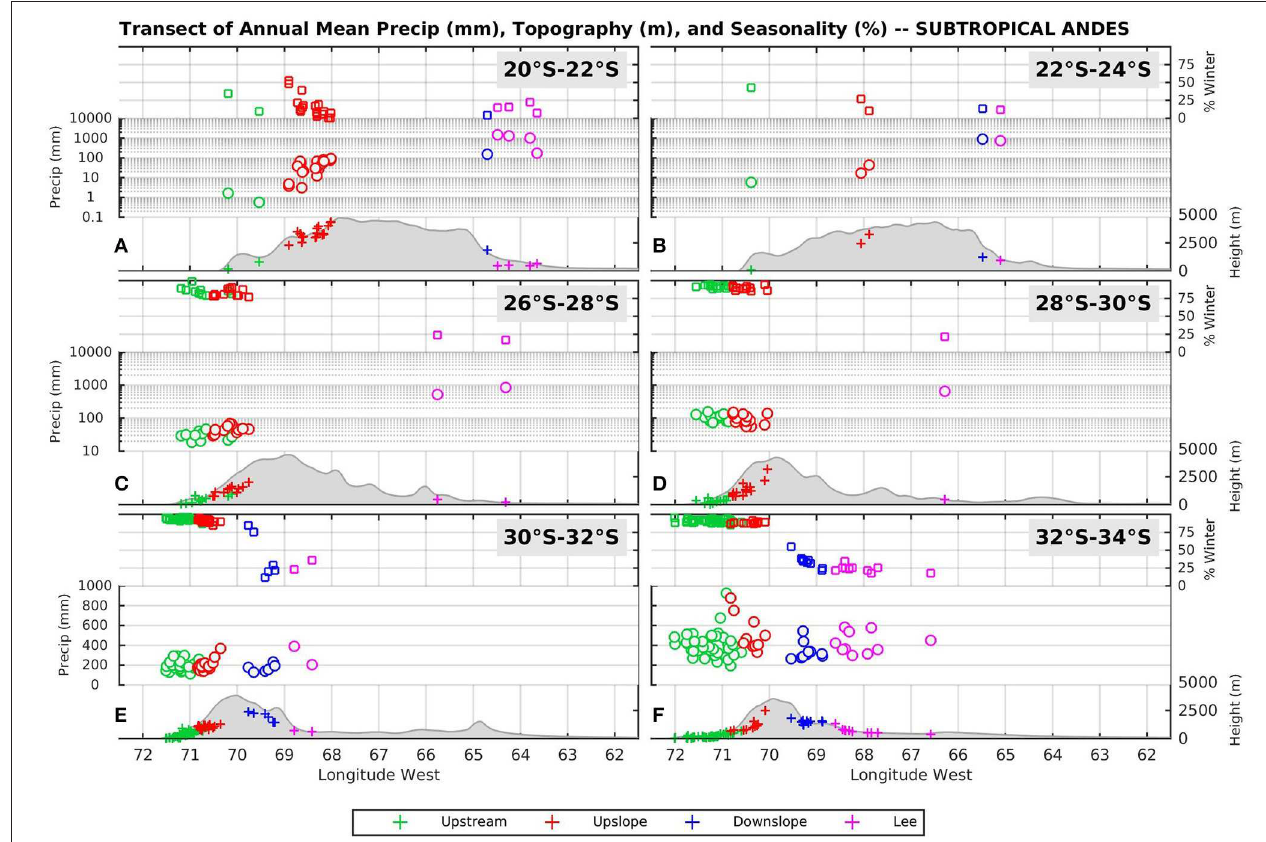
FIGURE 3 | Transects of annual precipitation (mm in the middle subpanel) and percentage of cold-semester (AMJJAS) precipitation to the annual total in the top subpanels, recorded by surface precipitation gauges across the subtropical Andes over the period 2006–2016. Each transect is plotted within a 2 ◦ width latitudinal band according to the data availability: (A) 20–22 ◦ S, (B) 22–24 ◦ S, (C) 26–28 ◦ S, (D) 28–30 ◦ S, (E) 30–32 ◦ S, and (F) 32–34 ◦ S. The mean cross-barrier altitude of the Andes and the elevation of surface sensors are plotted in each transect (at the inferior part of each subpanel). The different colors correspond to different cross-barrier zones where precipitation sensors are located (see legend below and section Data and Methods for